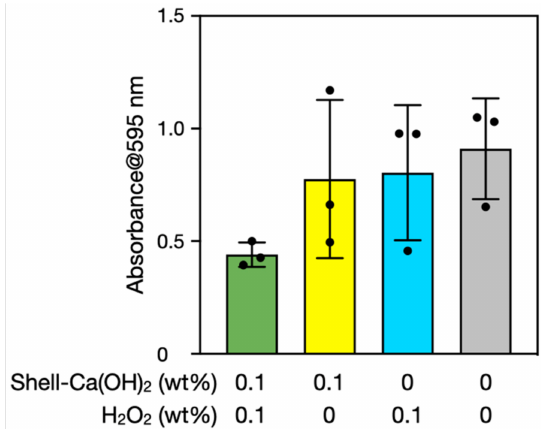
Figure 7. Semi-quantification of biofilms before and after the treatments with scallop shell-derived Ca(OH) 2 and/or H 2 O 2 for 10 min. The y -axis is the 595-nm absorbance of crystal violet extracted from the stained biofilms. The error bars represent the standard deviation of three individual